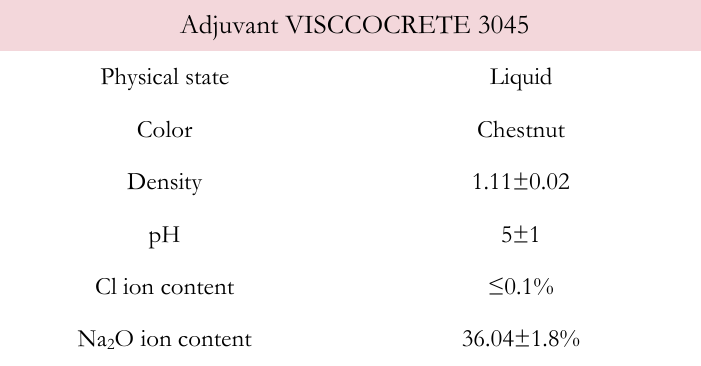
Table 6: Physical and chemical properties of plasticizer used according to the producer [53].